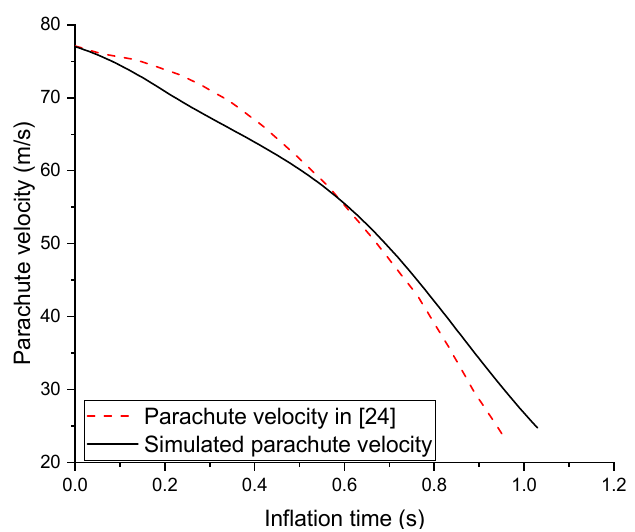
Figure 4. Comparison of parachute velocity during inflation with literature.